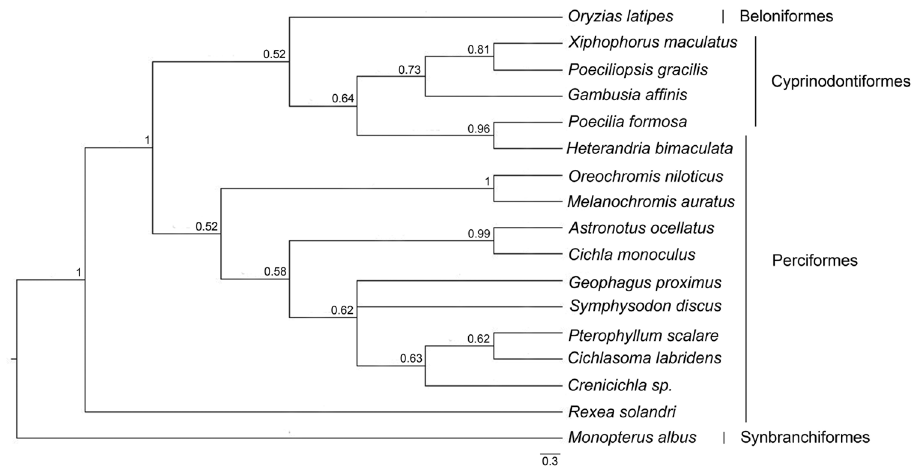
Figure 8. Phylogenetic placements of partial nucleotide sequences of Rex6 from 17 teleosts. Support values at each node are Bayesian posterior